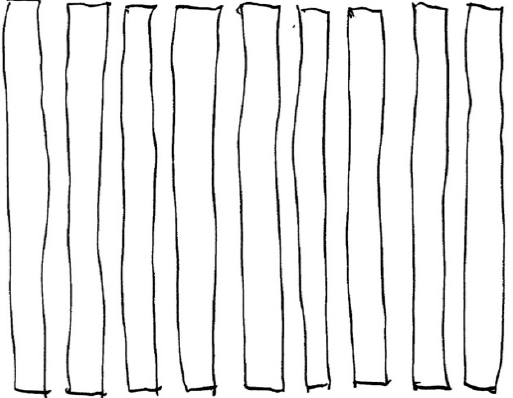
Figure 1. Unacceptable plan composed of monotonous low-rise buildings with no fractal qualities nor any useful urban space, following the industrial-modernist ideology.